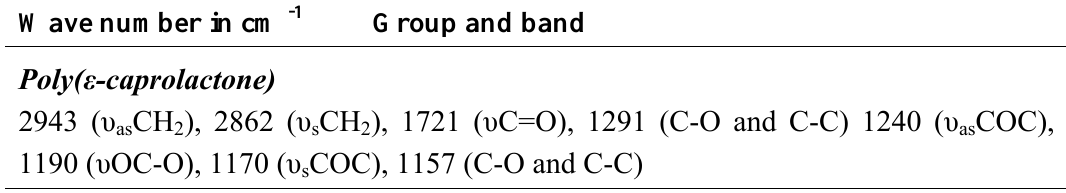
Table 3. Main absorption bands of the synthesized polyestres (spectrum recorded from a KBr